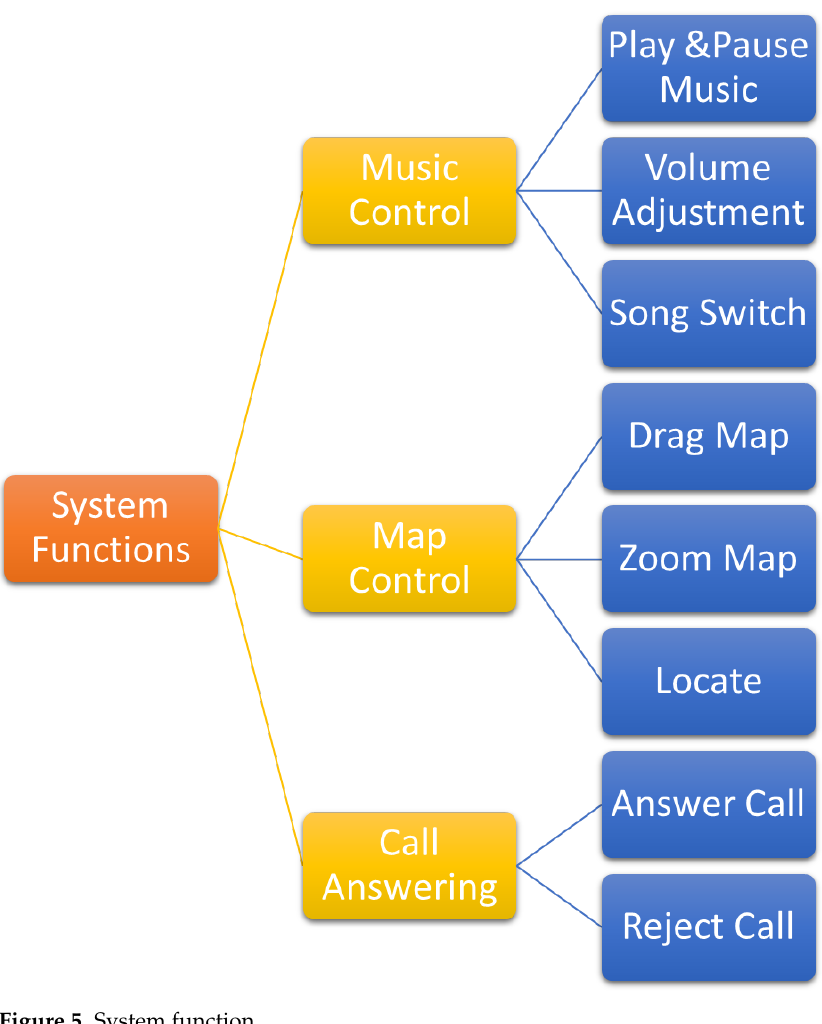
Figure 5. System